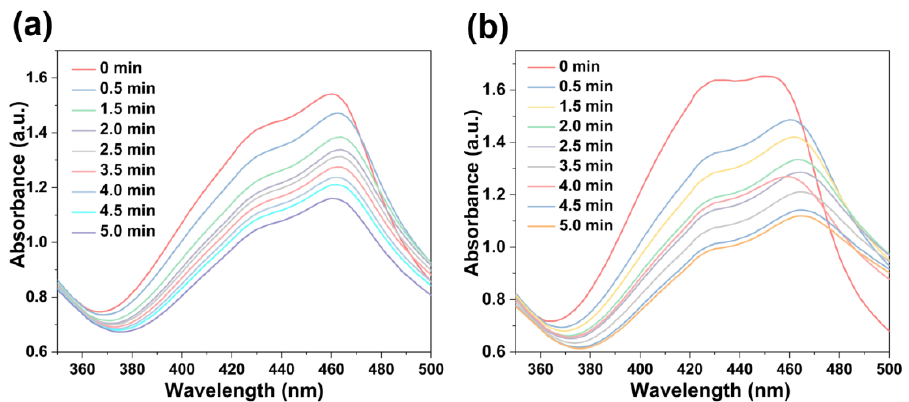
Figure 7. DPBF absorption changes in the presence of [Fe II -THPP-NPs] ( a ) and [Co II -THPP-flower] ( b ).